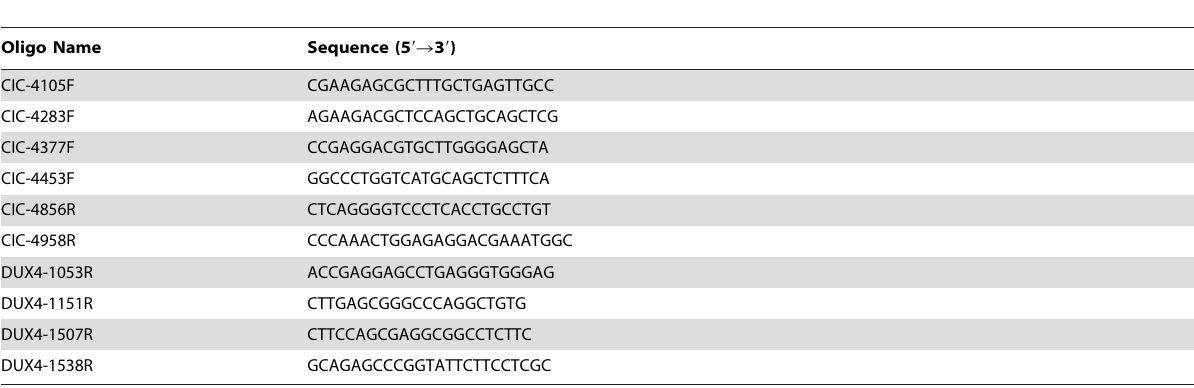
Table 1. Primers used for PCR amplifications and